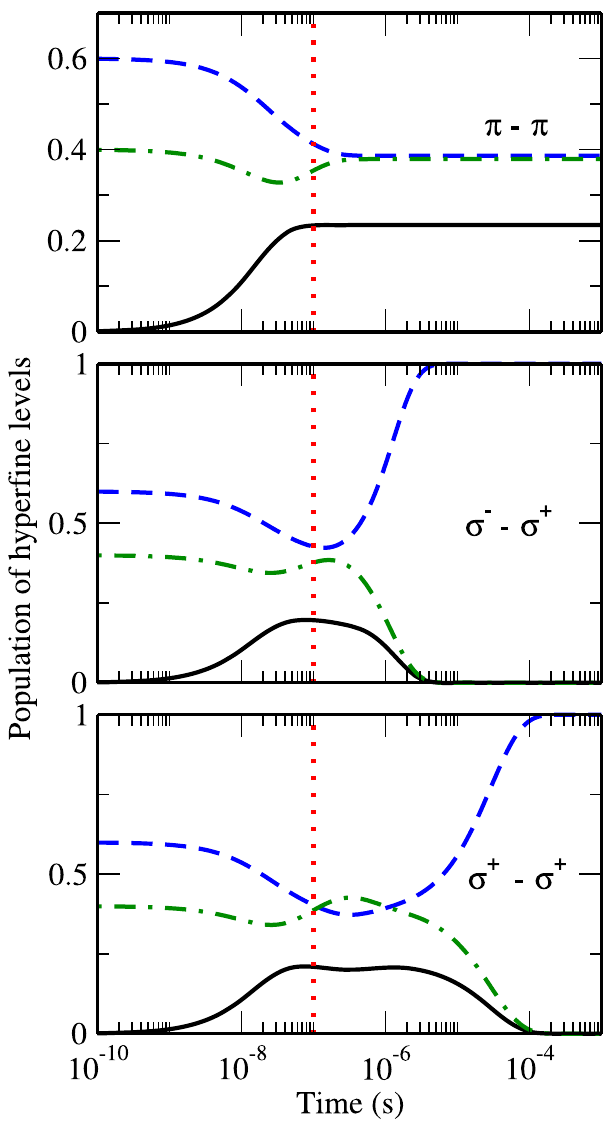
FIG. 5. The relative population of the 2 3 S 1 ∶ F 1 ¼ 3 = 2 (green dash-dotted line), 2 3 S 1 ∶ F 2 ¼ 5 = 2 (blue dashed line) and ∶ F ¼ 5 = 2 (black solid line) hyperfine levels of Li þ ions 2 3 P 2 3 as a function of time. The calculations have been performed for two counterpropagating laser beams that are both either linearly polarized in the horizontal plane (upper panel) or circularly polarized. For the latter case we consider two beams with the opposite σ − − σ þ (middle panel) and the same σ þ − σ þ (lower panel) polarizations. Finally, the red dotted vertical line marks the , that Li þ ions, moving with velocity v ¼ 0 . 338 c , need to time t det reach the center of the detection region from the point where they enter the laser-overlap P N ð t Þ ¼ N ð t Þ of the j 2 3 S ∶ F ¼ 3 = 2 i (green F i F i ;M Fi 1 1 M Fi dash-dotted line), j 2 3 S 1 ∶ F 2 ¼ 5 = 2 i (blue dashed line) and j 2 3 P ∶ F ¼ 5 = 2 i (black solid line) hyperfine level mani- 2 3